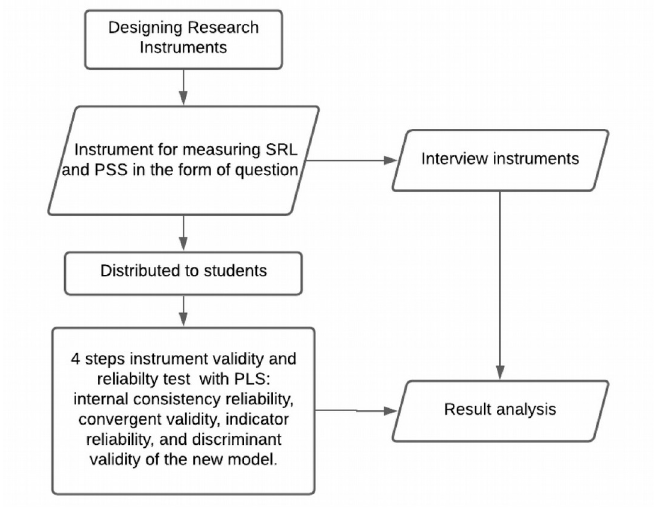
Figure 1. Research procedure